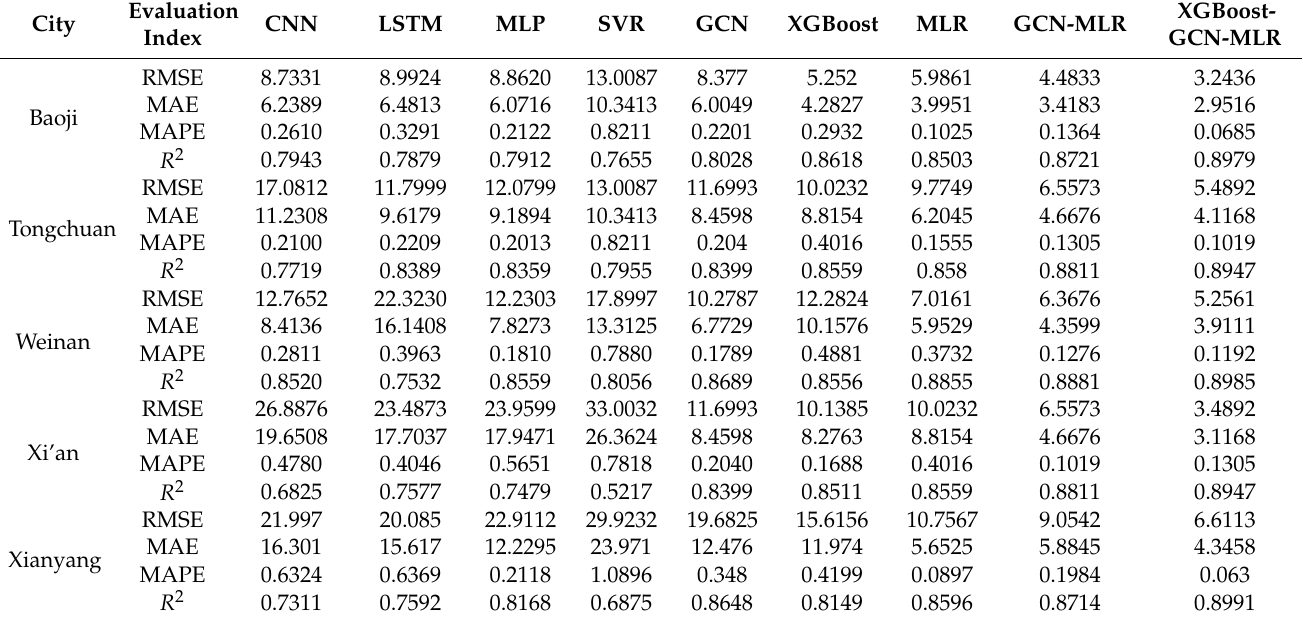
Table 4. Accuracy comparison of nine models in five cities.